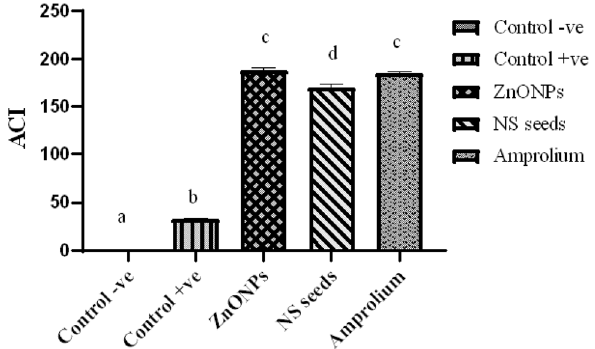
Figure 8. Anti-coccidial Index of the broilers challenged with Eimeria tenella and given different treatments. Bars with different superscripts are significantly different at ( p <